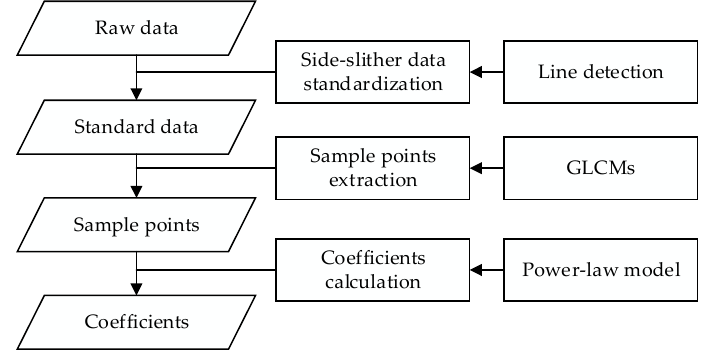
Figure 5. Proposed method based on the power-law model using side-slither data.